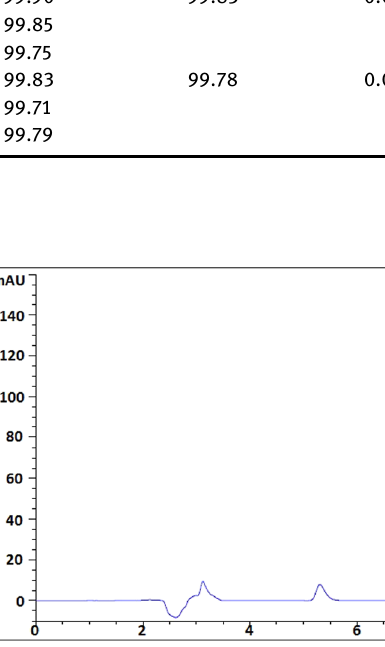
Figure 4: HPLC chromatogram of the sample solution at a concen - tration close to the quanti fi cation limit of the analyte ( 2.5 mg · mL − 1 )